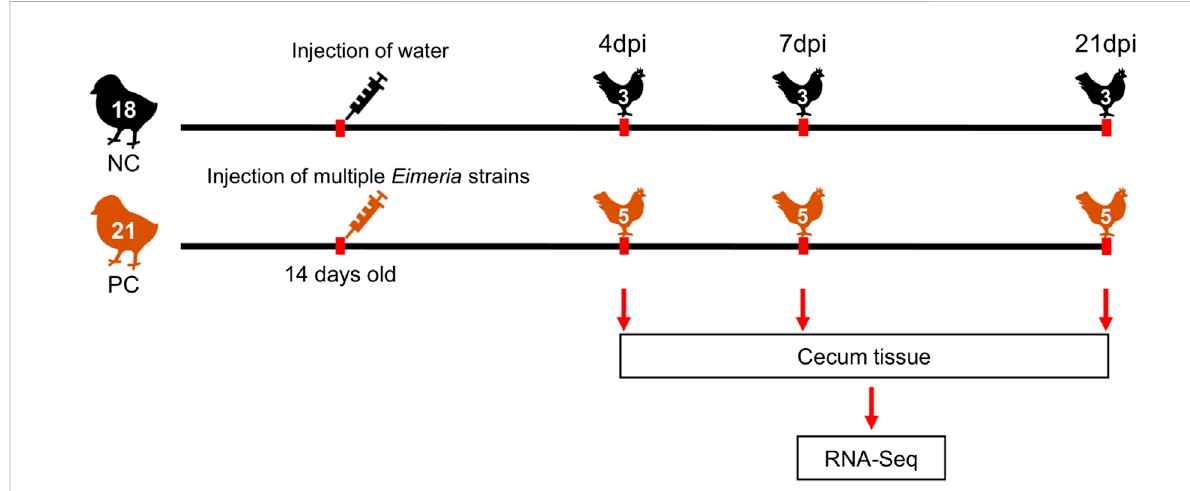
FIGURE 1 Overview of the experimental design. NC, Negative control; PC, Positive control; dpi, days